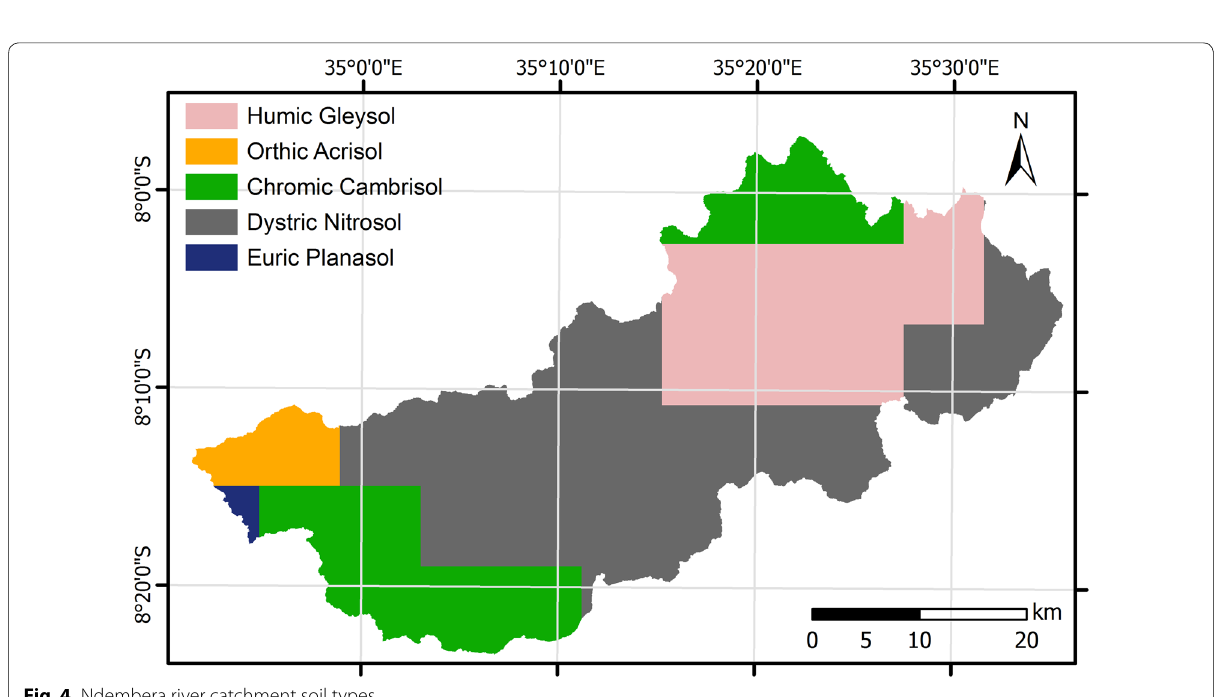
Fig. 4 Ndembera river catchment soil